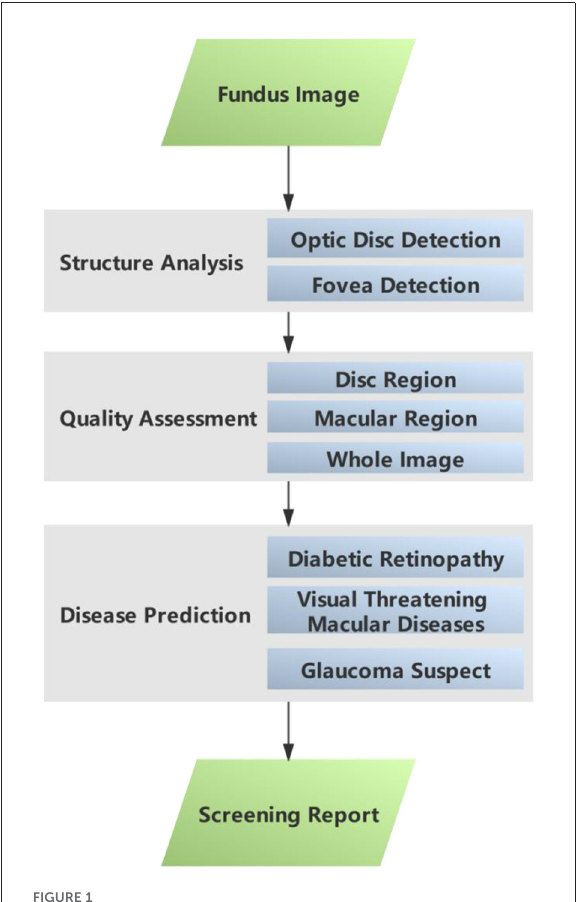
FIGURE1 Modules and processes in the AI-100 screening